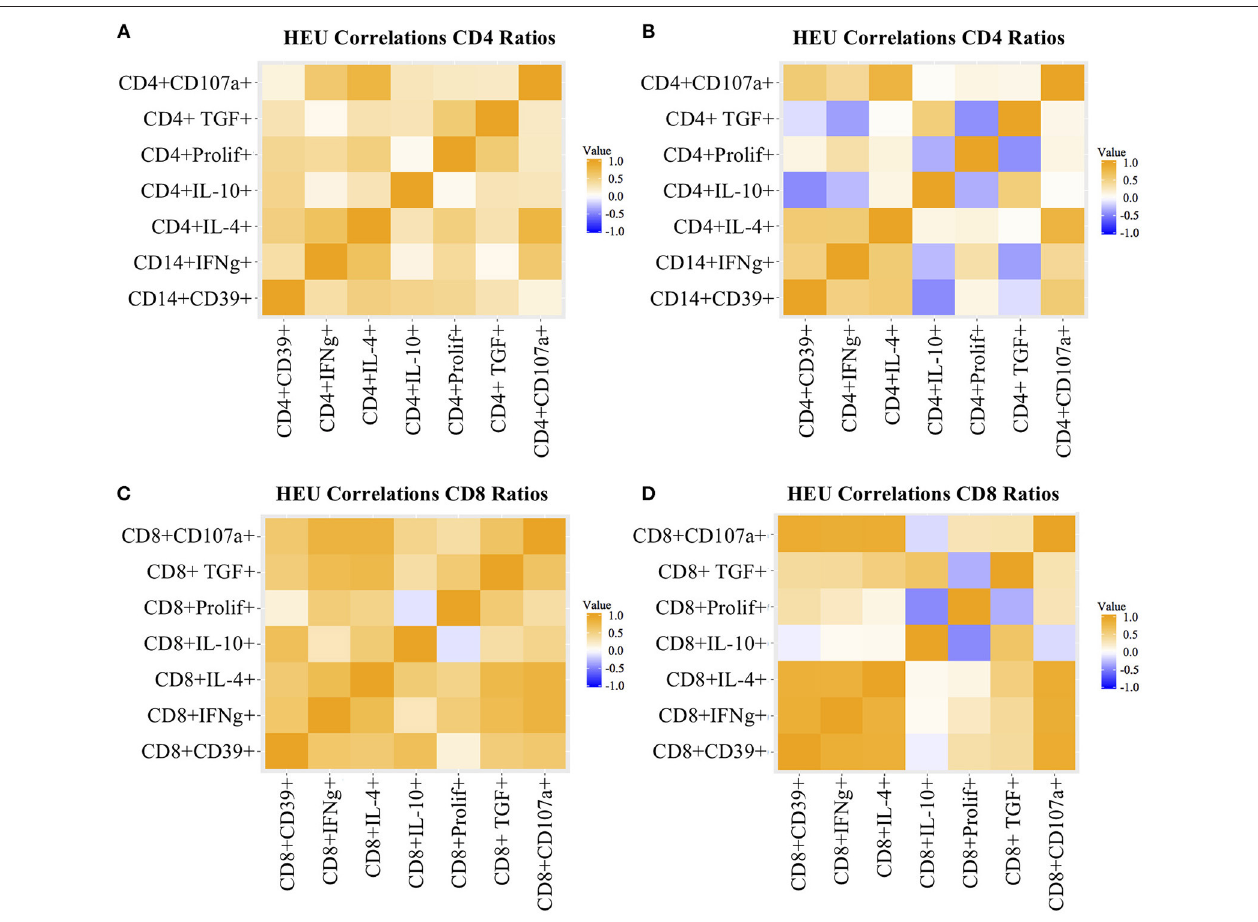
FIGURE 2 | Heatmap representation of functional T cell response correlations. Data were derived from PBMC of 22 HEU and 17 HUU after stimulation with SEB and mock. Analytes are shown on the graph axes. The correlation factor scale is shown on the side of each heatmap. The data represented in panels (A–D) are labeled in each of the corresponding